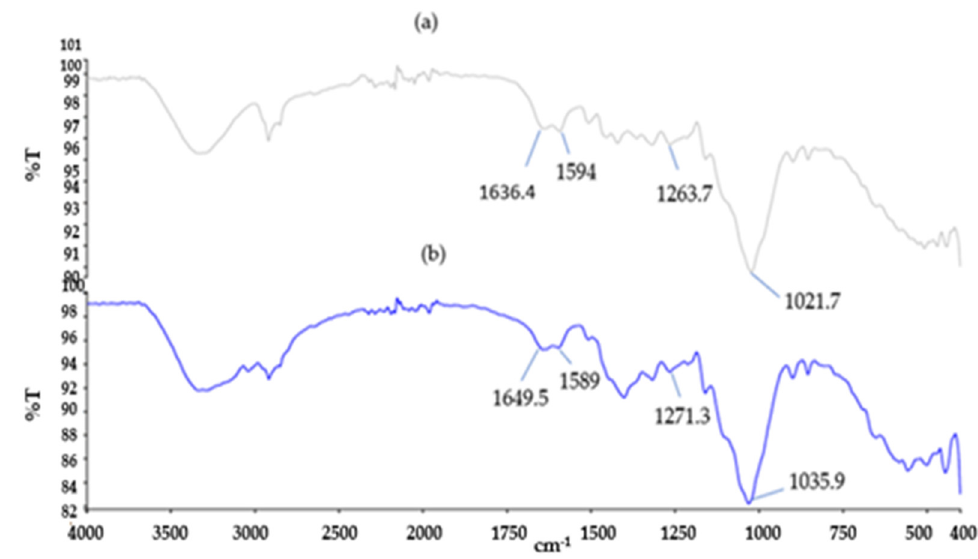
Figure 10. The comparison of FT–IR spectra between ( a ) C–PPF before adsorption and ( b ) C–PPF after adsorption.